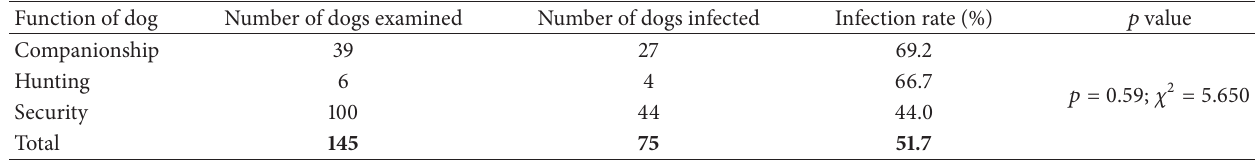
Table 2: Prevalence of helminths in relation to dog function.